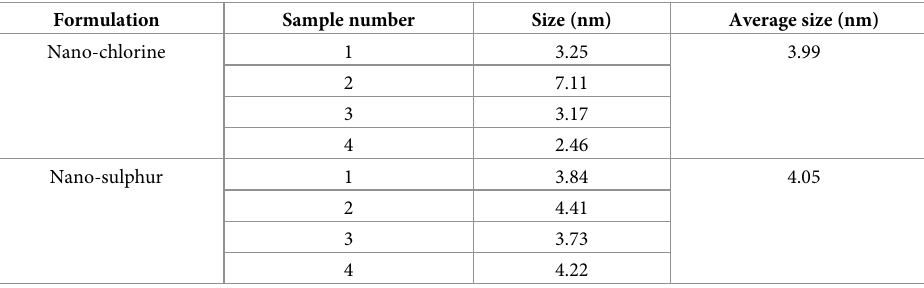
Table 1. Particle size of nano-chlorine, and